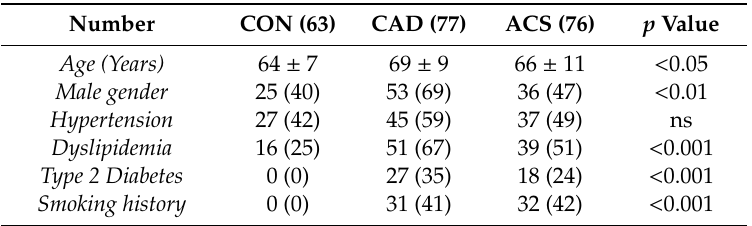
Table 1. Characteristics of study